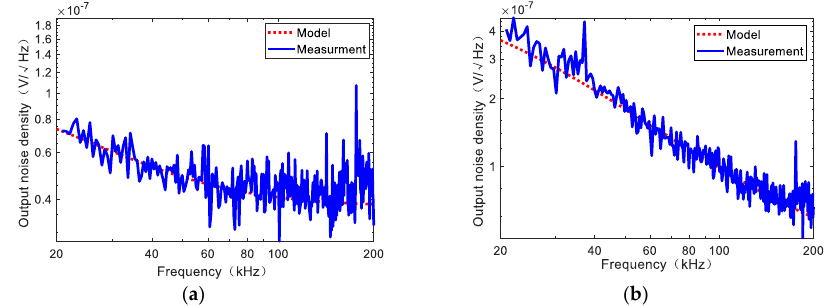
Figure 9. Photo of the electronic unit.